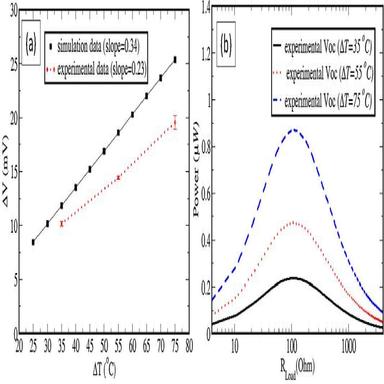
(a) Voltage output (ΔV) as a function of the temperature difference (ΔT) of the TEG-enabled CFRP with 10p-type CF-M40B thermocouples (simulation and experimental data), and (b) the thermoelectric power at ΔΤ of 35, 55 and 75 °C for varying load resistances. The peak power of 0.87 µW at ΔT = 75 Κ occurred when the RLoad matches the internal TEG resistance of 109.98 Ω.